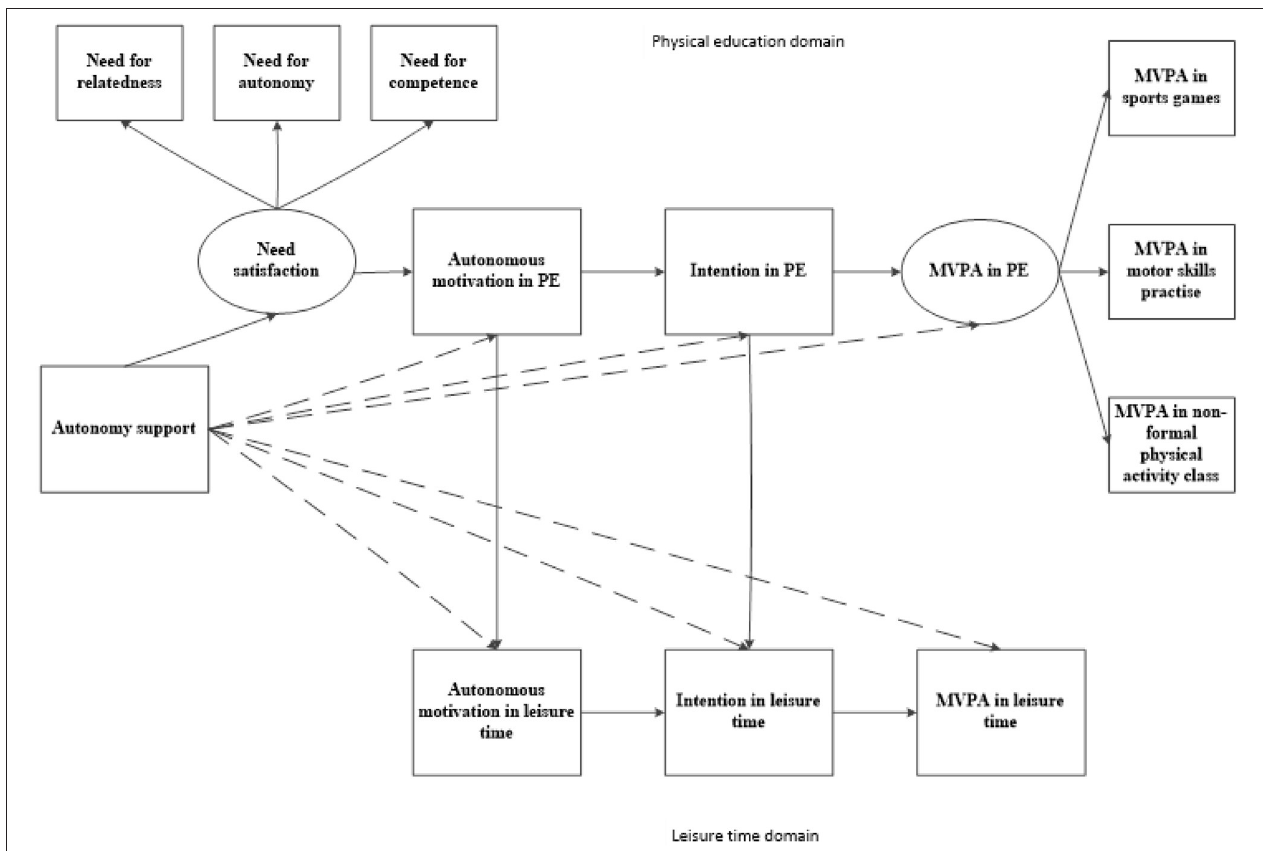
FIGURE 1 | A schematic diagram of the hypothesized relationships in a trans-contextual model. Solid arrows represent the hypothesized direct relationships, whereas the dashed represent the indirect